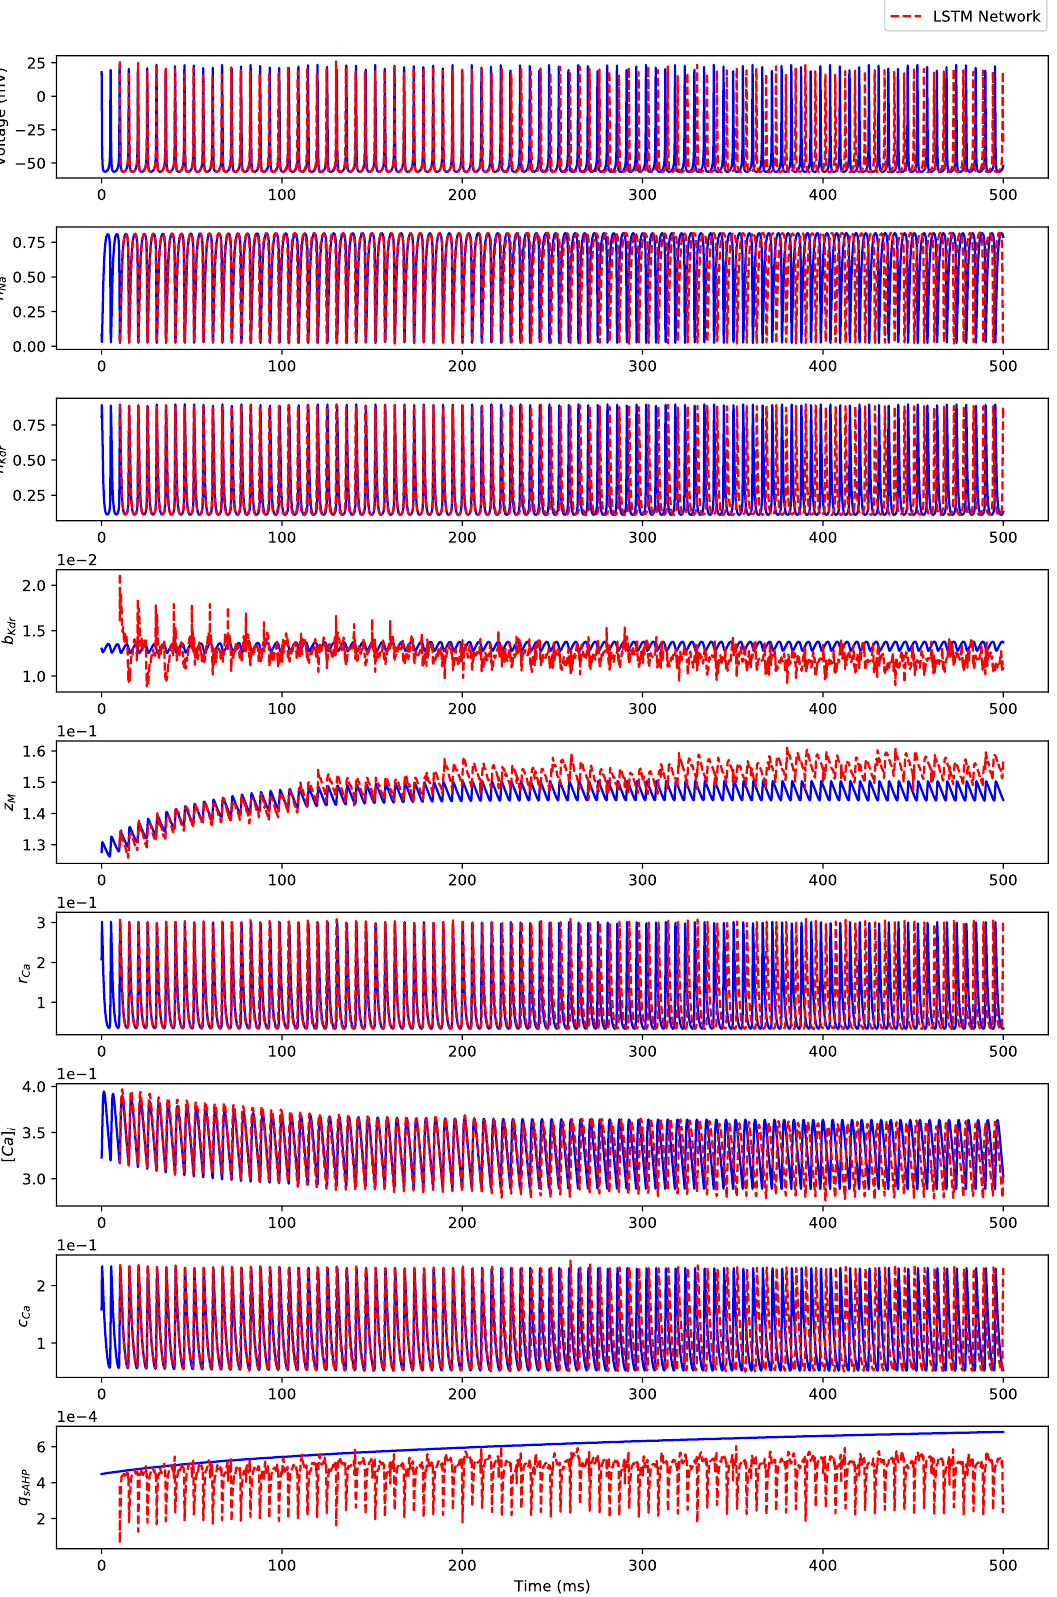
Figure A3. Comparison between the Hodgkin-Huxley model (“HH Model”) states’ dynamics and the iterative predictions of states’ dynamics using the 100 timesteps predictive horizon-based deep LSTM neural network (“LSTM Network”) in response to I = 3.0